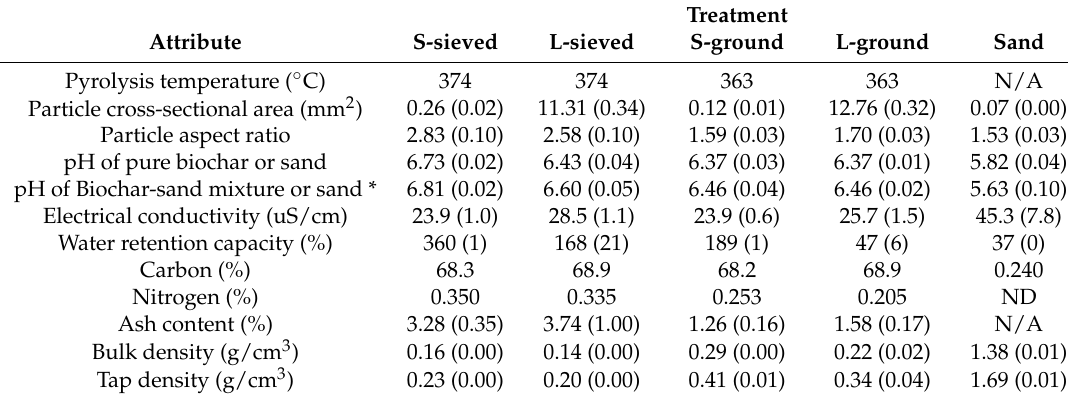
Table 1. Physical and chemical properties of biochars and sand. S-sieved, L-sieved, S-ground, and L-ground stand for small sieved biochar, large sieved biochar, small ground biochar, and large ground biochar, respectively. Means are listed with standard errors in parentheses. N/A indicates not applicable; ND indicates values below detection limit.